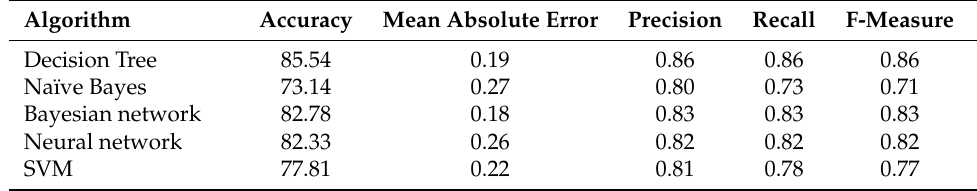
Table 8. Case study 2 results for summation division approach using cross-validation.